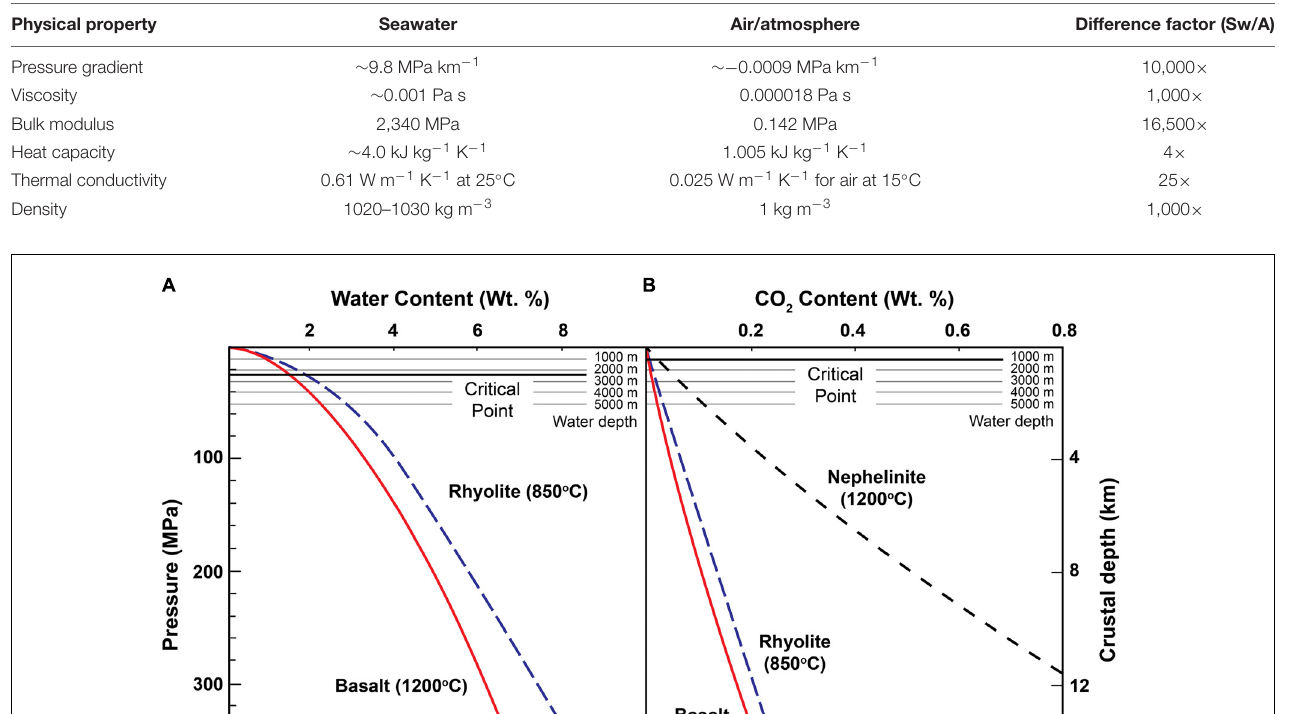
exsolution at 900 m water depth, and assuming ascent through a 20 m diameter cylindrical conduit, is about one quarter the original magmatic water content ( Figure 3B